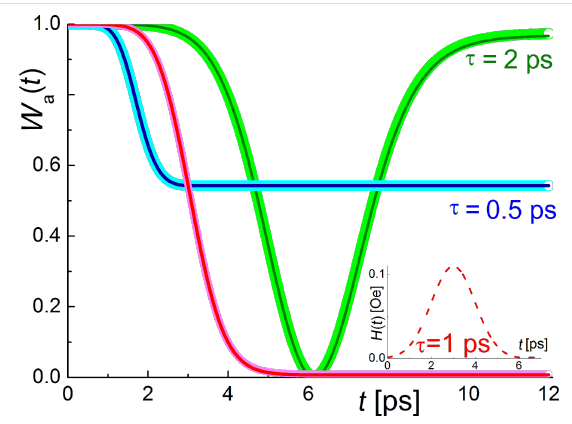
Figure 3: The dynamics of the ground level population, W a , of the flux qubit system (µ 12 = 10 6 µ 0, ω 12 ≈ 10 10 Hz, a 0 = 1, b 0 = 0) for the case of a unipolar Gaussian magnetic field pulse ( H 0 ≈ 0.1 Oe, t 0 = 3 τ ). The filled circles are the numerical calculations and the solid lines are the analytical approaches described using Equation 14 and Equation 15. The magnetic field acting on the system is presented in the inset (dashed